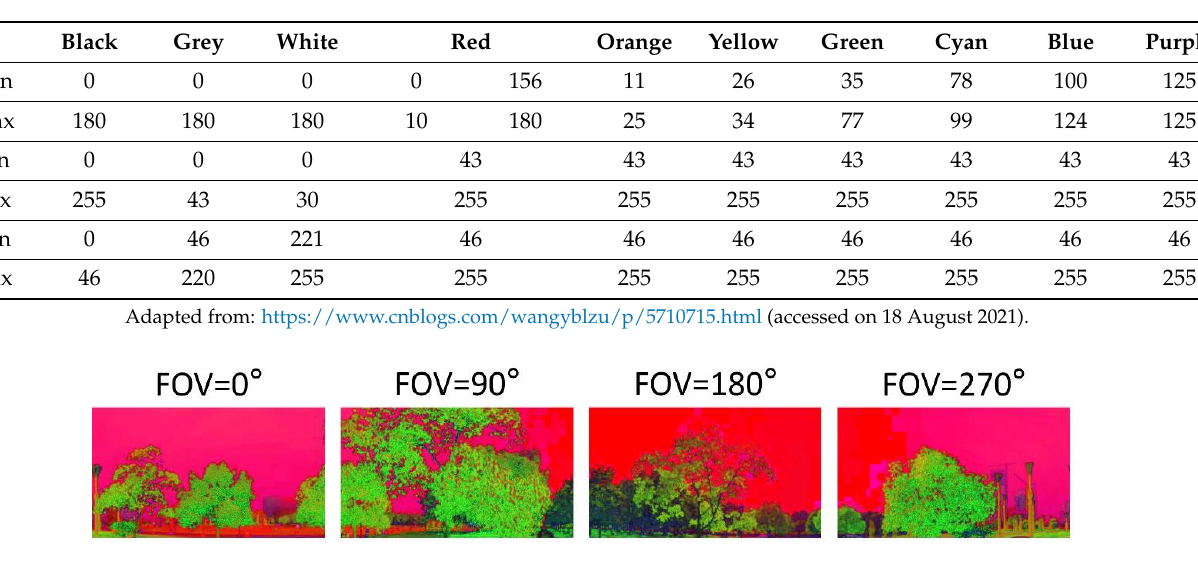
Figure 6. Thiessen polygon of each sampling point in Jiang Su Lu county (jiedao). 2.4. Socioeconomic and Built Environment Variables With the purpose of exploring the equity of the spatial distribution of street greenery, we selected two categories of variables, and their data are accessible from census data and other data companies (Table 2). On the basis of previous social-justice and environmental- equity studies, one category is socioeconomic variables, including population density, ra- tio of vulnerable population, and housing price [14,41]. Since the studied county level is a comparatively microscale of urban areas, limited socioeconomic data could be obtained from the Internet. Among socioeconomic variables, population density and the ratio of vulnerable groups on the county or jiedao level were extracted and preprocessed from the sixth nationwide census data [42], in which other indicators such as gender, educational background, and income were recorded as more large-scale aggregate data on the city level. In addition, housing-price data at the county or jiedao level are useful to more ac- curately evaluate the economic status of residents [43]; in this study, data were crawled from LianJia, a well-known real-estate agent in China. The built-environment variable may directly impact the spatial distribution of the GVI through the capacity for construct- ing street greenery, including point-of-interest (POI) diversity and street-network density [14,44]. Through calculations via the street length and area of the county, the density of the street network determines the space of street greenery in a given block, especially walkable streets for pedestrians, since the two sides of expressways are usually guardrails.